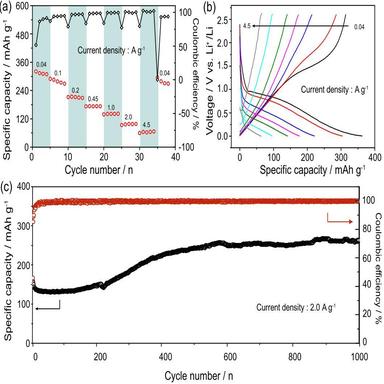
(a, b) High-rate capabilities of LMB/BxOy@C at various current densities from 0.04 A g1 to 4.5 A g1 . (c) The cycling performances of LMB/BxOy@C at 2.0 A g1 .